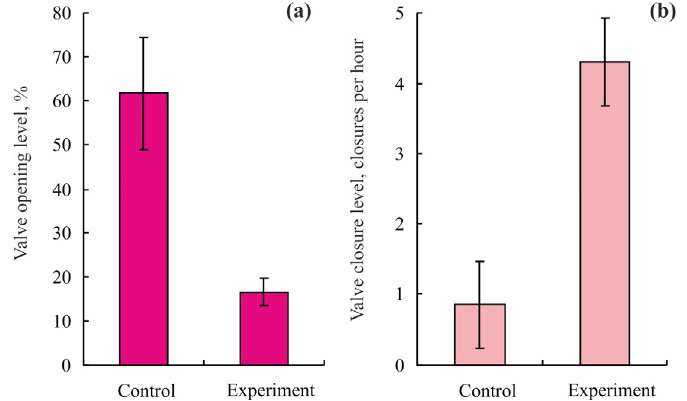
Figure 8. Valve activity levels of Iceland scallops Chlamys islandica from the Barents Sea (adopted from [94]): ( a ) valve opening level after the exposure to diesel oil (5 mg L − 1 ), ( b ) valve closing frequency after the exposure to diesel oil (15 mg L − 1 ).